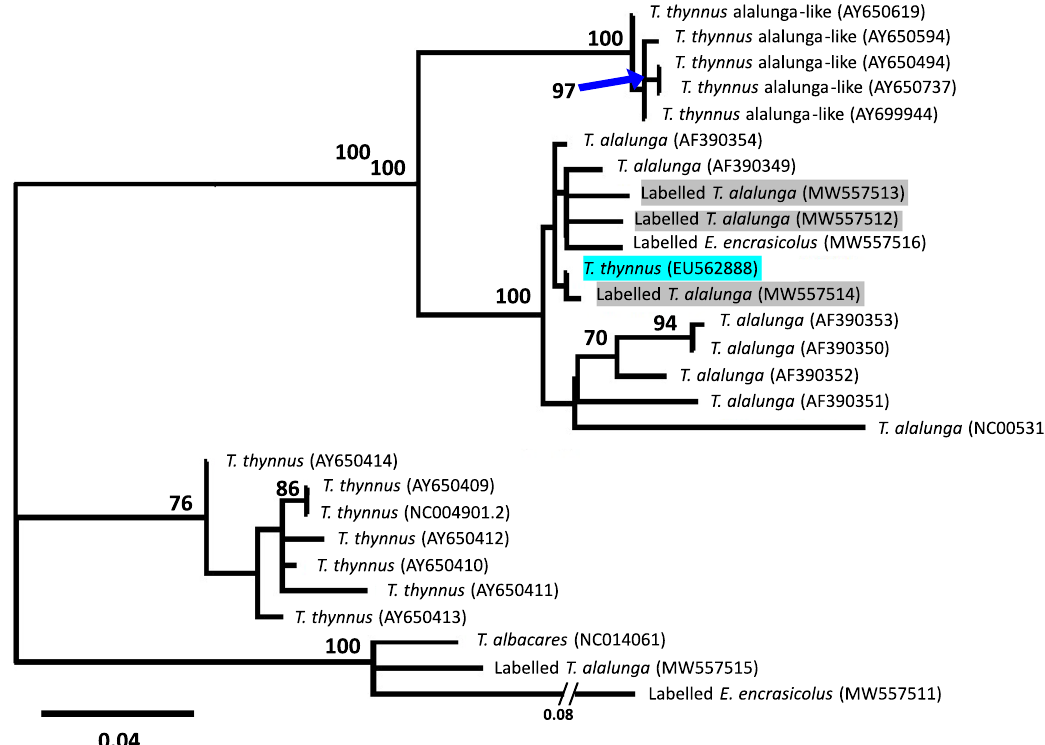
Figure 1. Maximum likelihood phylogenetic tree built using the GTR CAT model as implemented in RAxML version 8.1.21 9 based on the mitochondrial control region (positions with less than 50% missing data between 5 to 414 of NC005317 sequence) aligned using Clustal W 10 (default parameters) including all the available tuna identified sequences from Blanco-Fernandez et al . (MW557511-16) with the ones labelled T. alalunga matching to T. thynnus labelled in grey, the best BLAST hit T. thynnus sequence (EU562888), shaded in blue, and reference sequences from T. albacares (NC014061), T. alalunga (AF390349-54), T. thynnus (AY650409-14 and NC004901) and T. thynnus “alalunga-like” (AY650494, AY650594, AY650619, AY650737, AY699944). The tree is